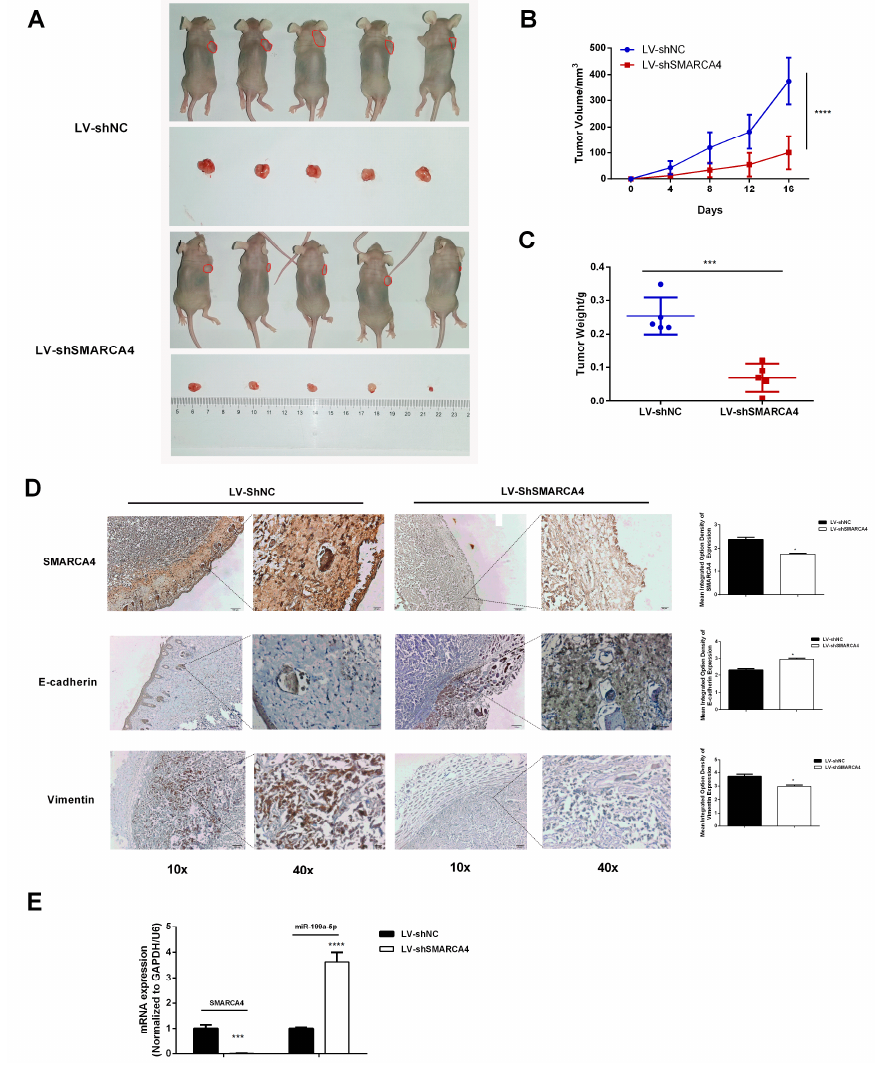
Figure 8. Knockdown of SMARCA4 suppresses OSCC tumorigenesis associated with upregulated miR199-a-5p in vivo. ( A ) Xenograft nude mice were injected with SAS cells stably transfected